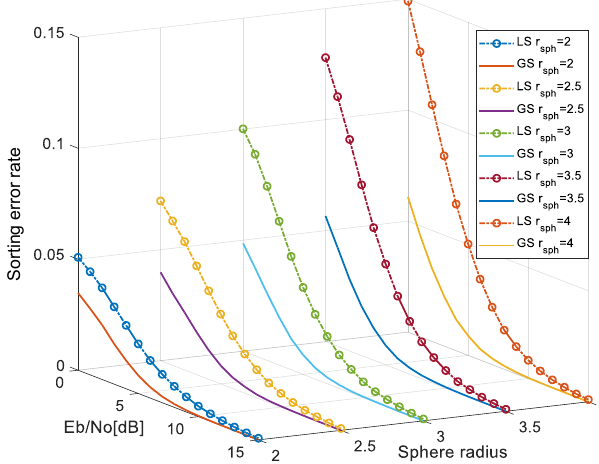
Figure 4. The sorting error rate at 5 -th level using two sorting models: the local sorting (LS) that takes the 4 local best nodes and the global sorting (GS) that takes the global best 4 nodes for 4 × 4 MIMO with 16 -QAM.